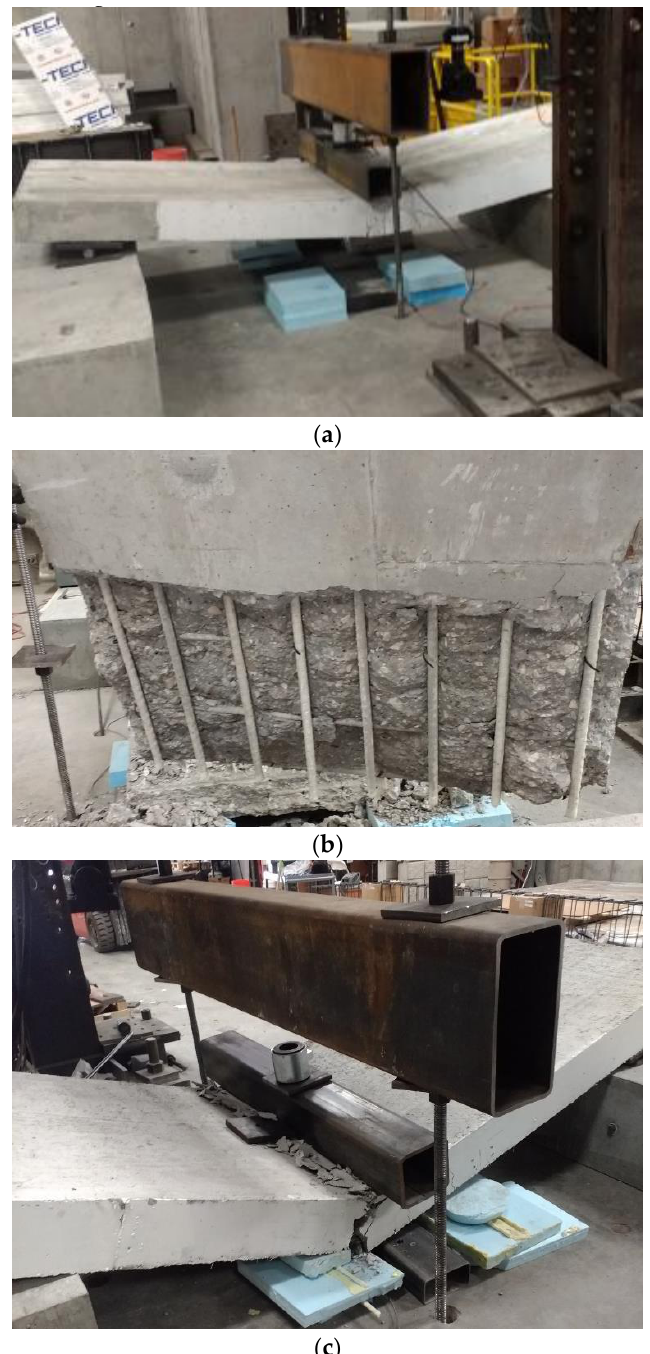
Figure 10. Failure mode of specimens tested post-fatigue for flexural strength ( a ) steel reinforced deck, ( b ) GFRP deck, and ( c ) Hybrid deck.